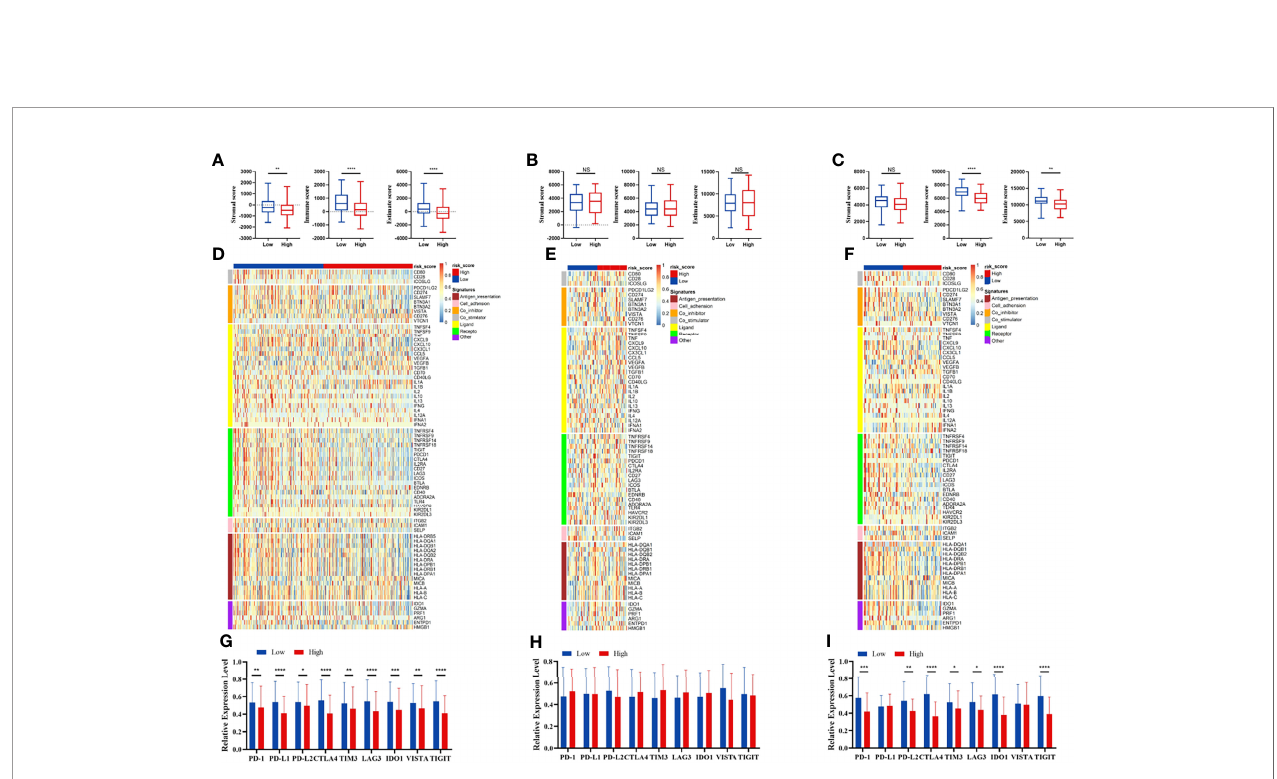
FIGURE 8 | Immune patterns of the risk score model. Comparison of stromal scores, immune scores, and estimate scores between the high-risk and low-risk patients in the TCGA (A) , GSE42743 (B) , and GSE41613 (C) . The expression level of immune-related signatures in the TCGA (D) , GSE42743 (E) and GSE41613 (F) . The expression level of immune checkpoint molecules in the TCGA (G) , GSE42743 (H) and GSE41613 (I) . All p -values for signi fi cance (<0.05) represent comparisons via two- tailed t -test and multiple t -tests with FDR < 0.05. * p -value<0.05, ** p -value<0.01, *** p -value<0.001, **** p -value<0.0001, and NS (not signi fi